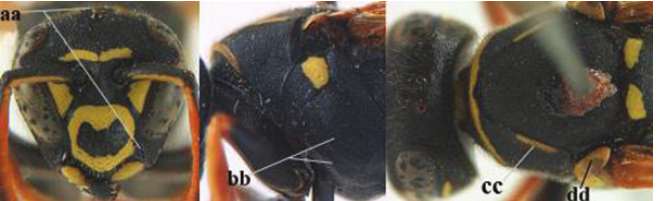
– Malar space 0.87–1.19 times as long as POL (aa); change in sculpture and level between mesepisternum and epicnemium often gradual (bb; = epicne- mial ridge absent or obsolescent); yellow lateral stripes of pronotum present (cc; but absent in Mongolian specimens); tegula in most specimens entirely yellow, at most blackish subbasally (dd); pubescence of mesoscutum on av- erage 0.7 times as long as greatest diameter of anterior ocellus; C Europe, temperate Asia .......................................... P. albellus Giordani Soika, 1976